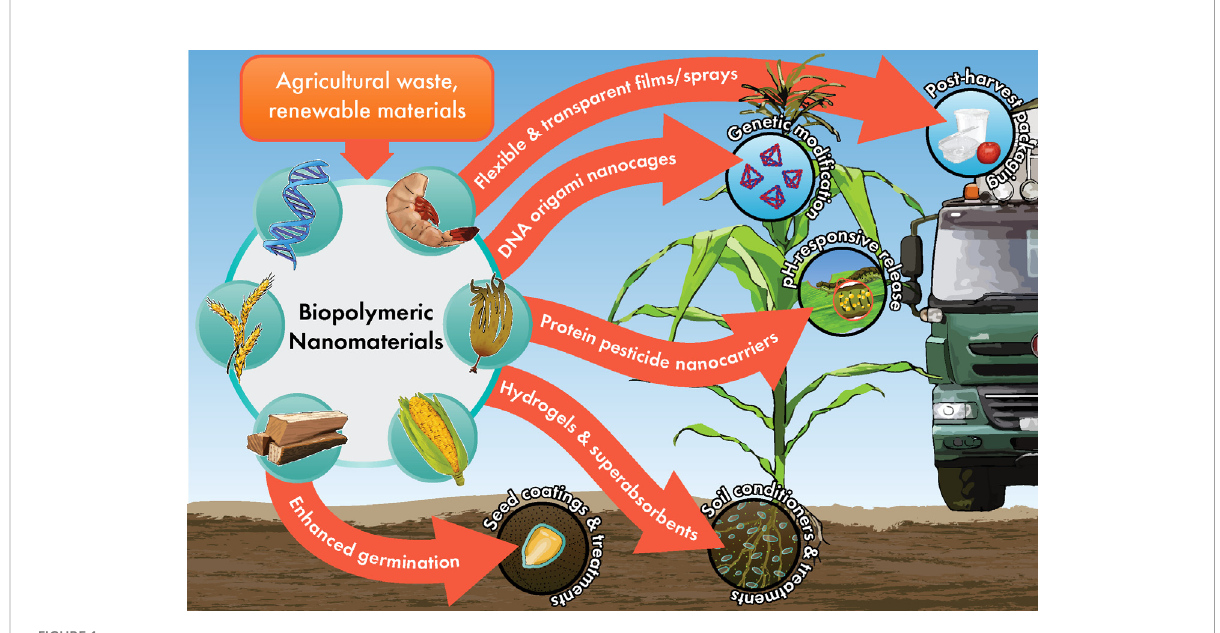
FIGURE 1 Potential agricultural applications of biopolymeric